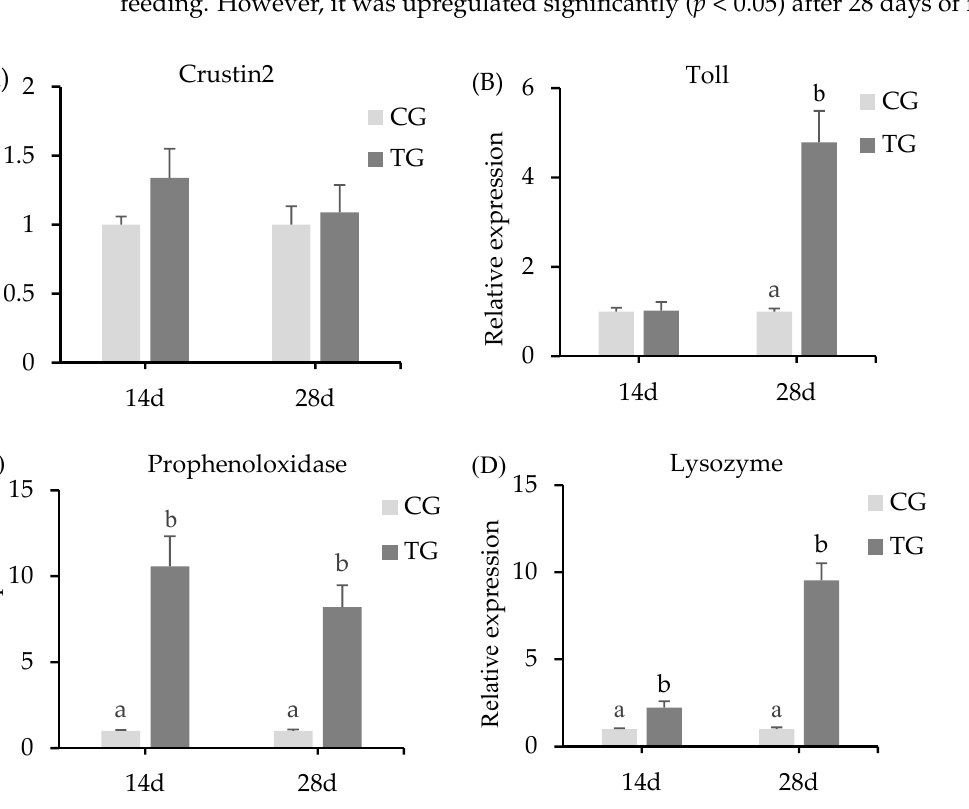
Figure 1. Intestinal morphology analysis of crayfish fed with different experimental diets for 14